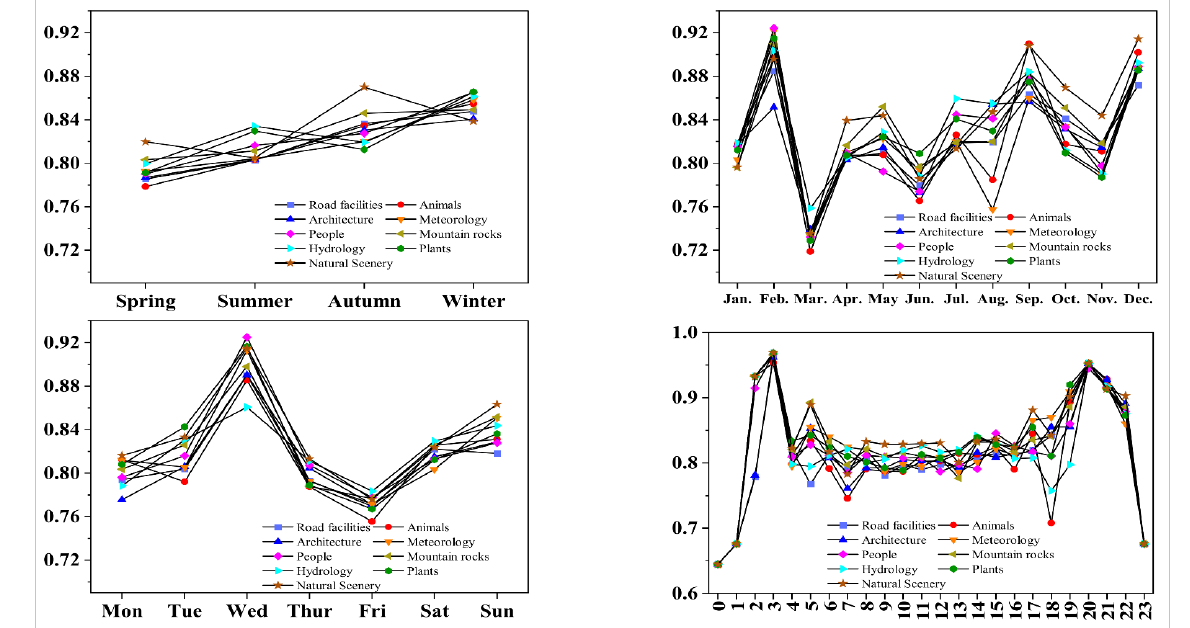
Figure 7. Emotional value of tourists’ photos on a scale of seasons, months, weeks, and